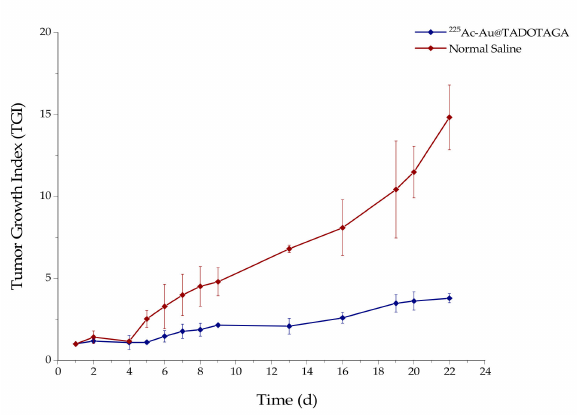
Figure 5. E ff ect of intratumoral injection of [ 225 Ac] 225 Ac-Au@TADOTAGA (blue line) or normal saline (red line) on the tumor growth index (TGI) of U-87 MG tumor-bearing SCID mice. Values represent the mean ± SD ( n = 5 mice per group).